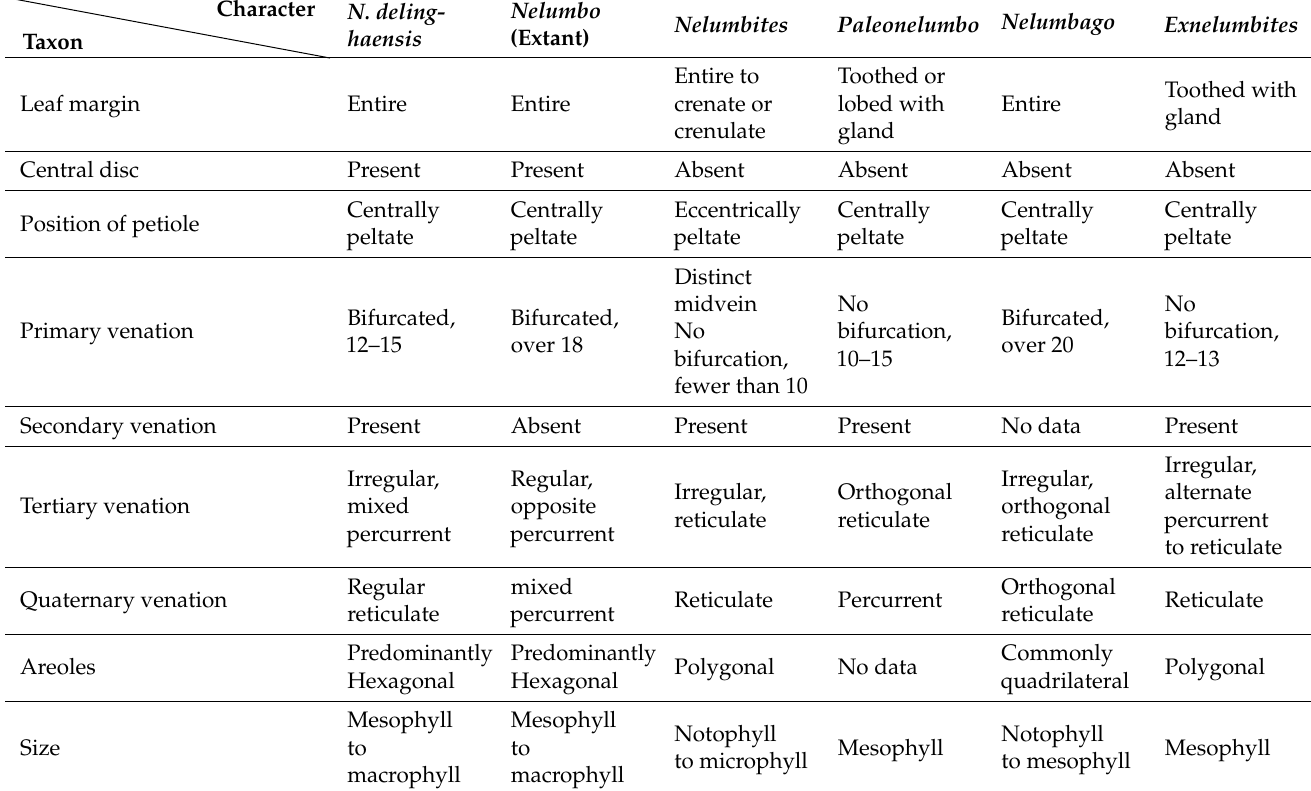
Table 1. Comparisons of leaf features between Nelumbo and the stem group of